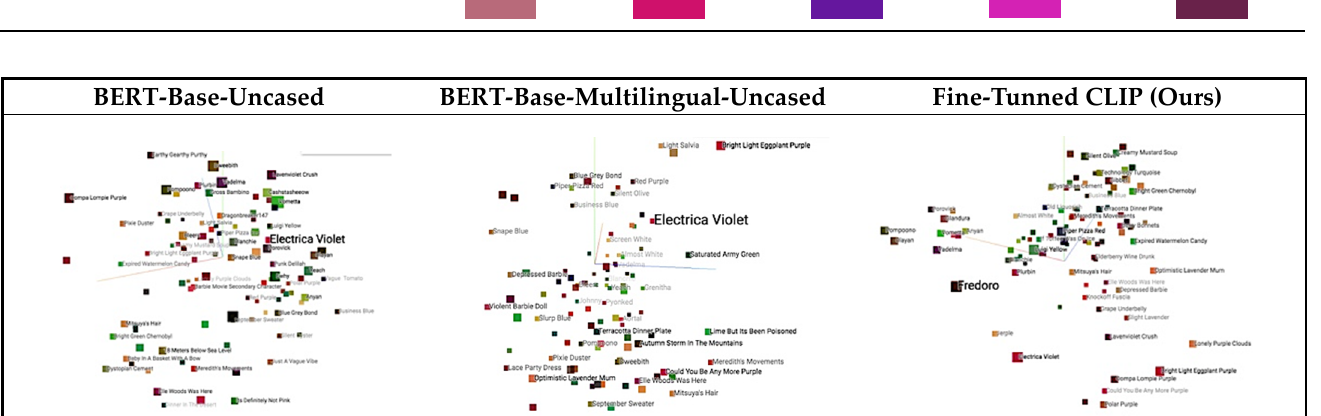
Figure 16. Linguistic space visualization.